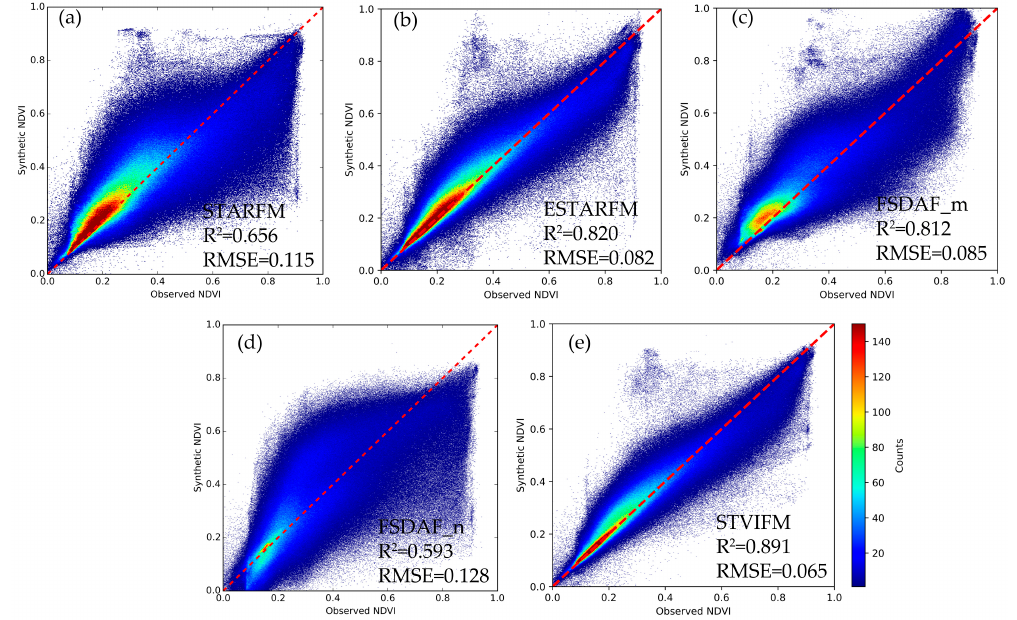
Figure 14. Scatter plot of observed and synthetic Landsat NDVI by: STARFM ( a ); ESTARFM ( b ); FSDAF_m ( c ); FSDAF_n ( d ); and STVIFM ( e ) in Xinjiang, China.